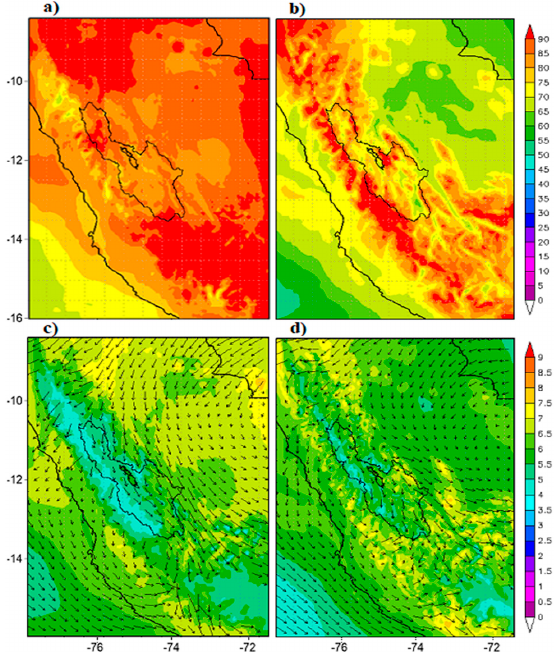
Figure 15. WRF-simulated relative humidity (%) (top) and water-vapor mixing ratio (bottom) (g/kg), averaged over the 700–500 hPa layer at 07 LST (Local Standard Time) ( a , c ) and 13 LST ( b , d ) of 2 February 2011.